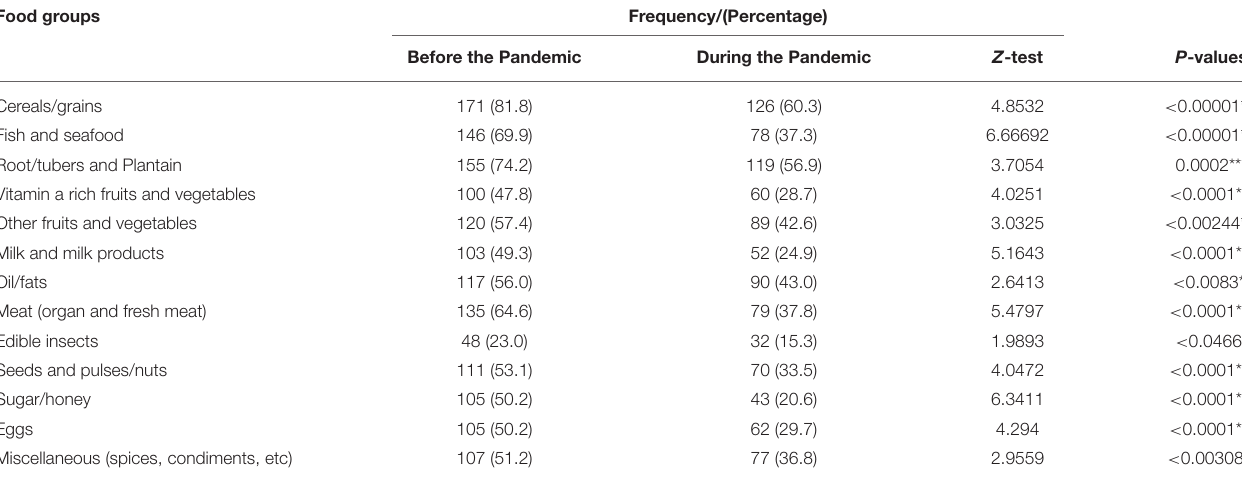
TABLE 3 | Reported food groups consumed before and during the Pandemic. Food